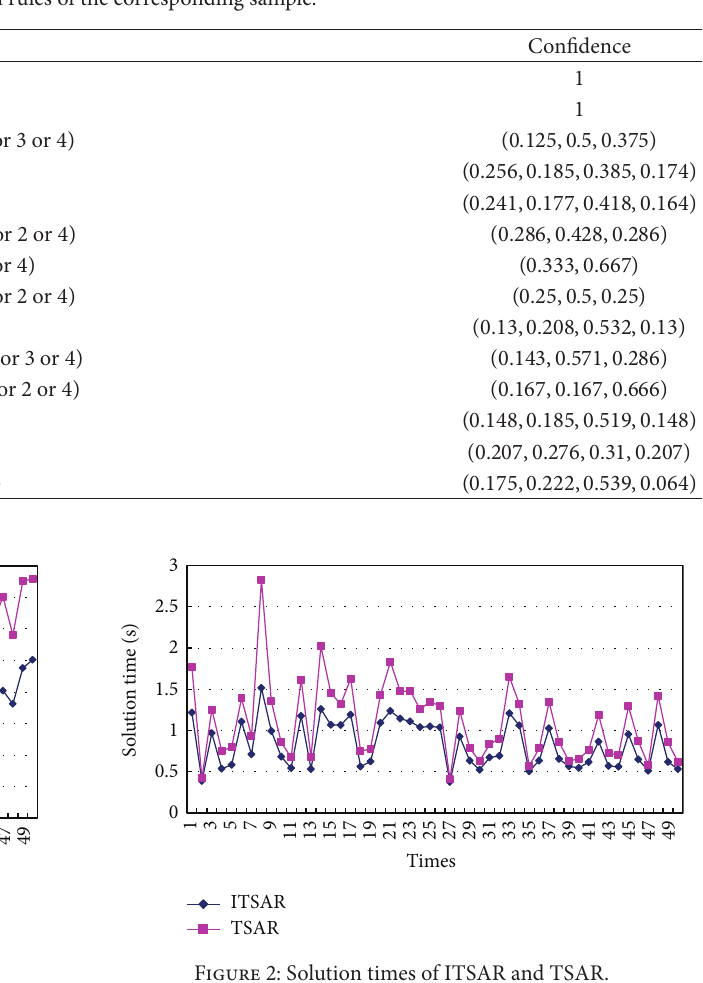
Table 5: Decision rules of the corresponding sample.